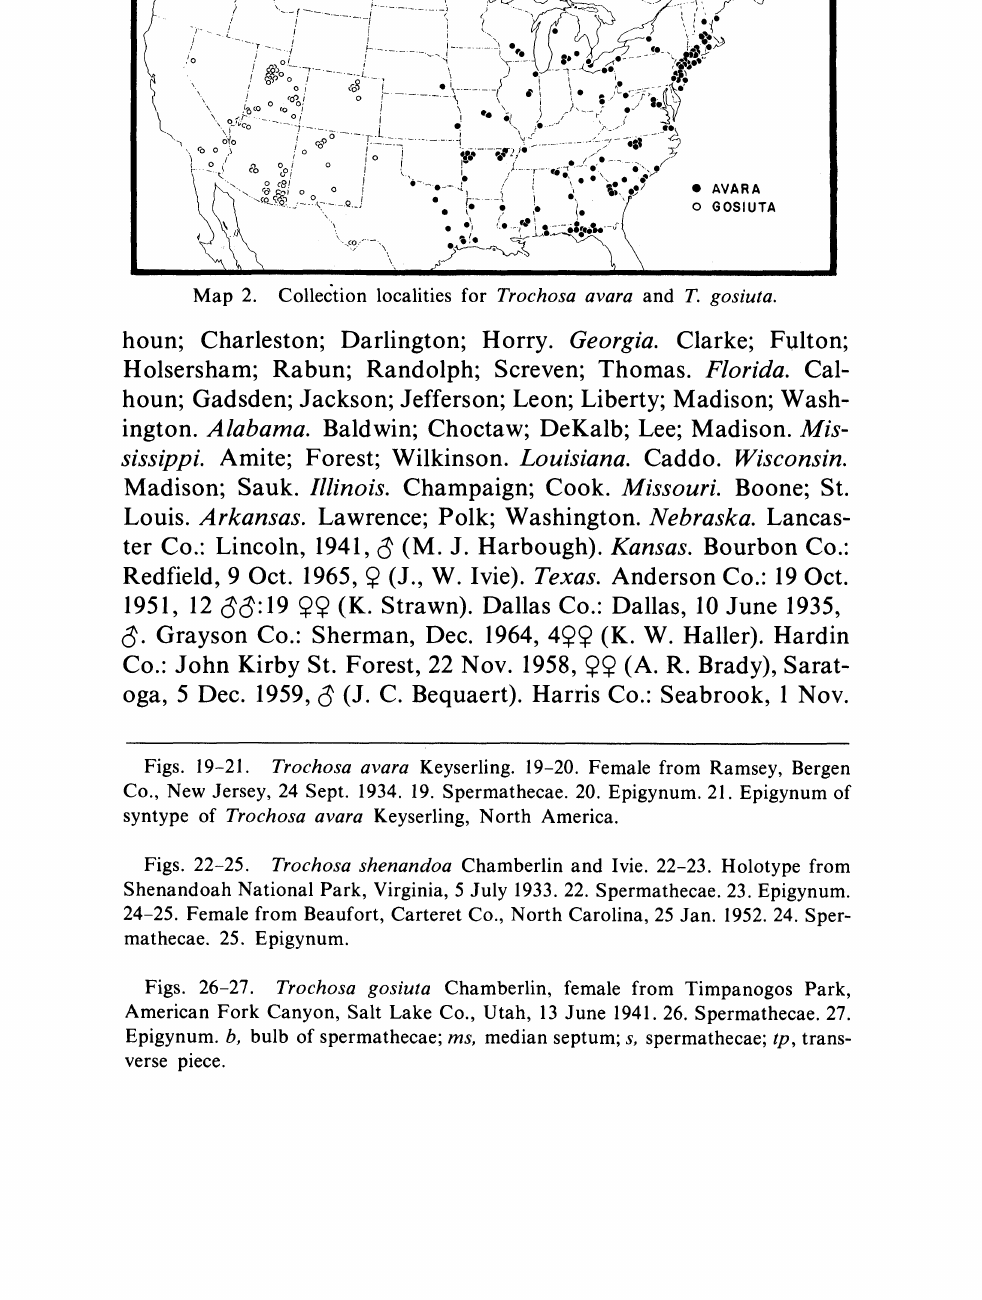
Epigynum. b, bulb of spermathecae; ms, median septum; s, spermathecae; tp, trans- verse